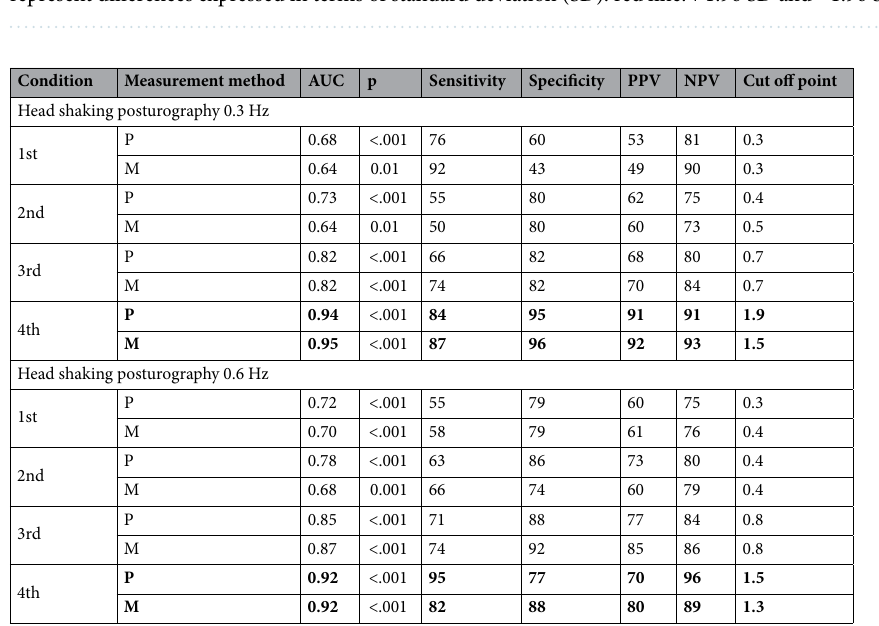
Table 1. Sensitivity, specificity (the optimum cut-off point for the maximum value of Youden’s index), areas under the receiver operating characteristic (ROC) in simultaneous measurements on the platform posturography (P) and the inertial sensor (M) attached to the lumbar L4. Conditions: 1st (eyes open/stable surface), 2nd (eyes closed/stable surface), 3rd (eyes open/foam), 4th (eyes closed/foam). The most significant results are in bold. P platform posturography, M MediPost (IMU), AUC area under curve, PPV positive predictive value, NPV negative predictive value.